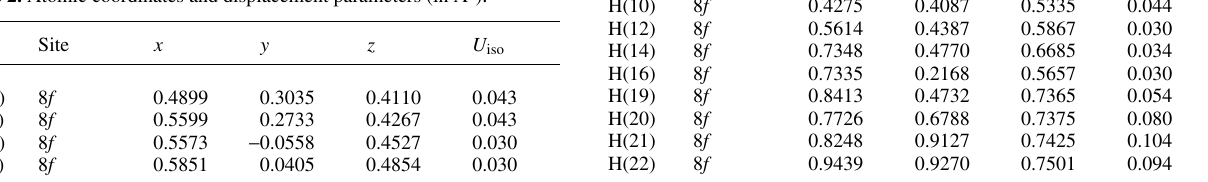
Table 2. Atomic coordinates and displacement parameters (in Å 2 ) .